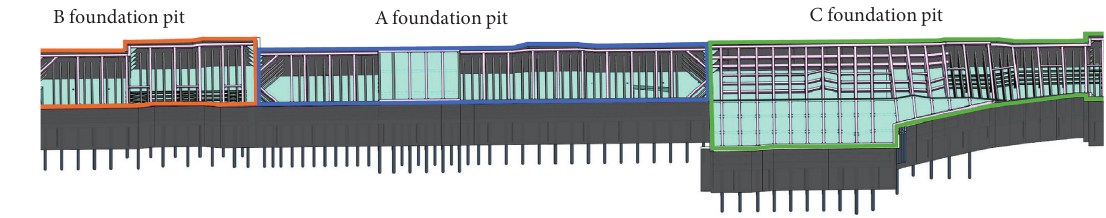
Figure 1: Schematic diagram of a foundation Table 1: Physical and mechanical parameters of the soil layer.